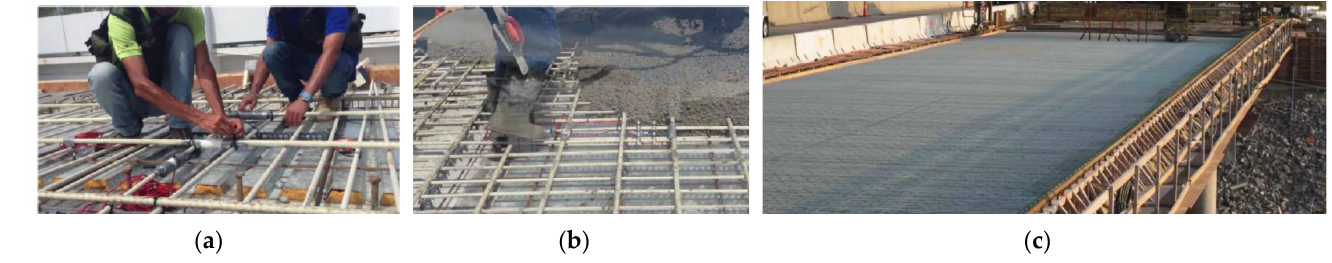
Figure 1. Demonstration project for FRP-SSC bridge decks: ( a ) FRP mesh; ( b ) concrete casting; ( c ) bridge deck (Adapted from Ref. [8]).